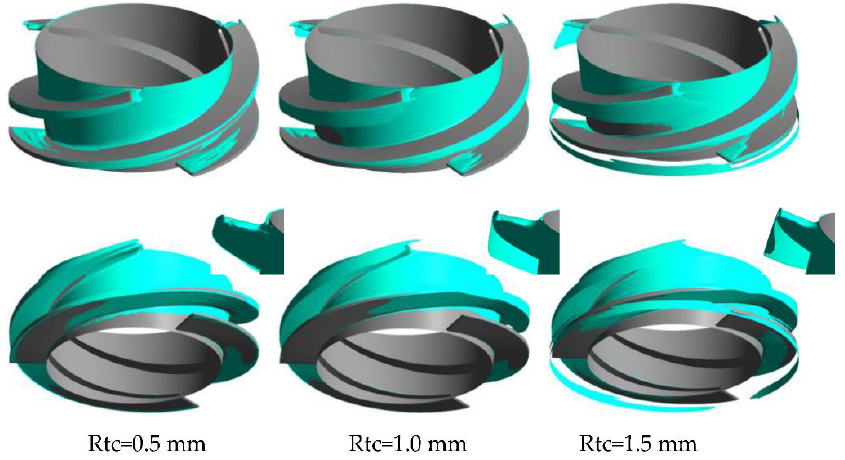
Figure 9. Gas distribution in the impeller at IGVF = 10%.